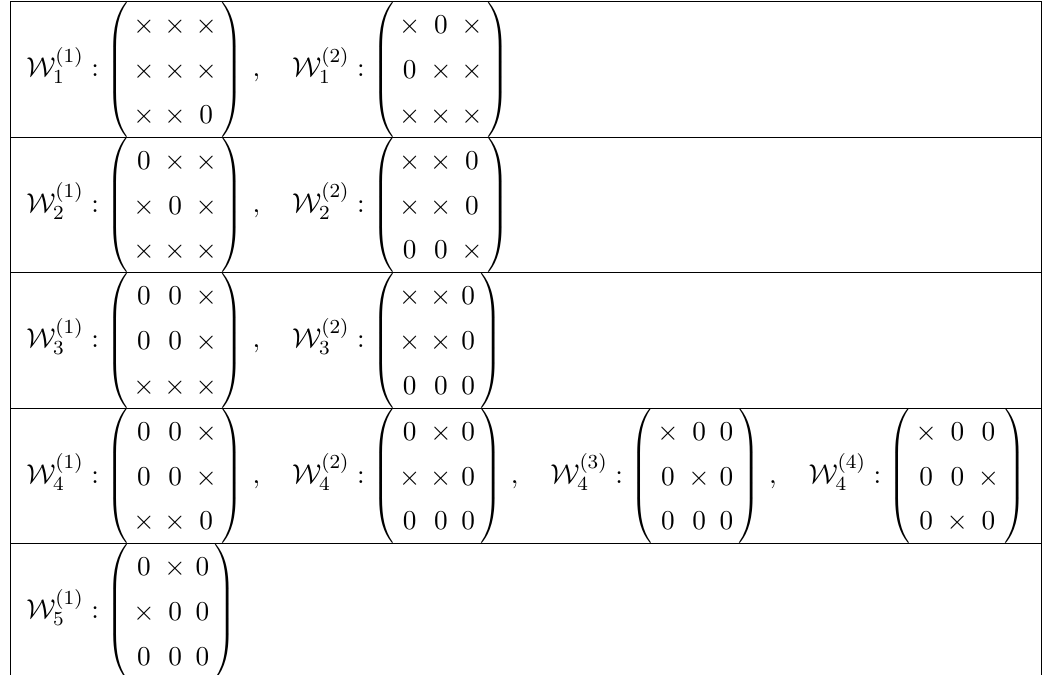
Table 4. Texture-zero patterns for the Majorana neutrino mass matrix M ν which can be realised by T 0 modular symmetry, up to row and column permutations. Notice that only W (1) , W (2) , W (1) and W (4) W (1) 3 3 4